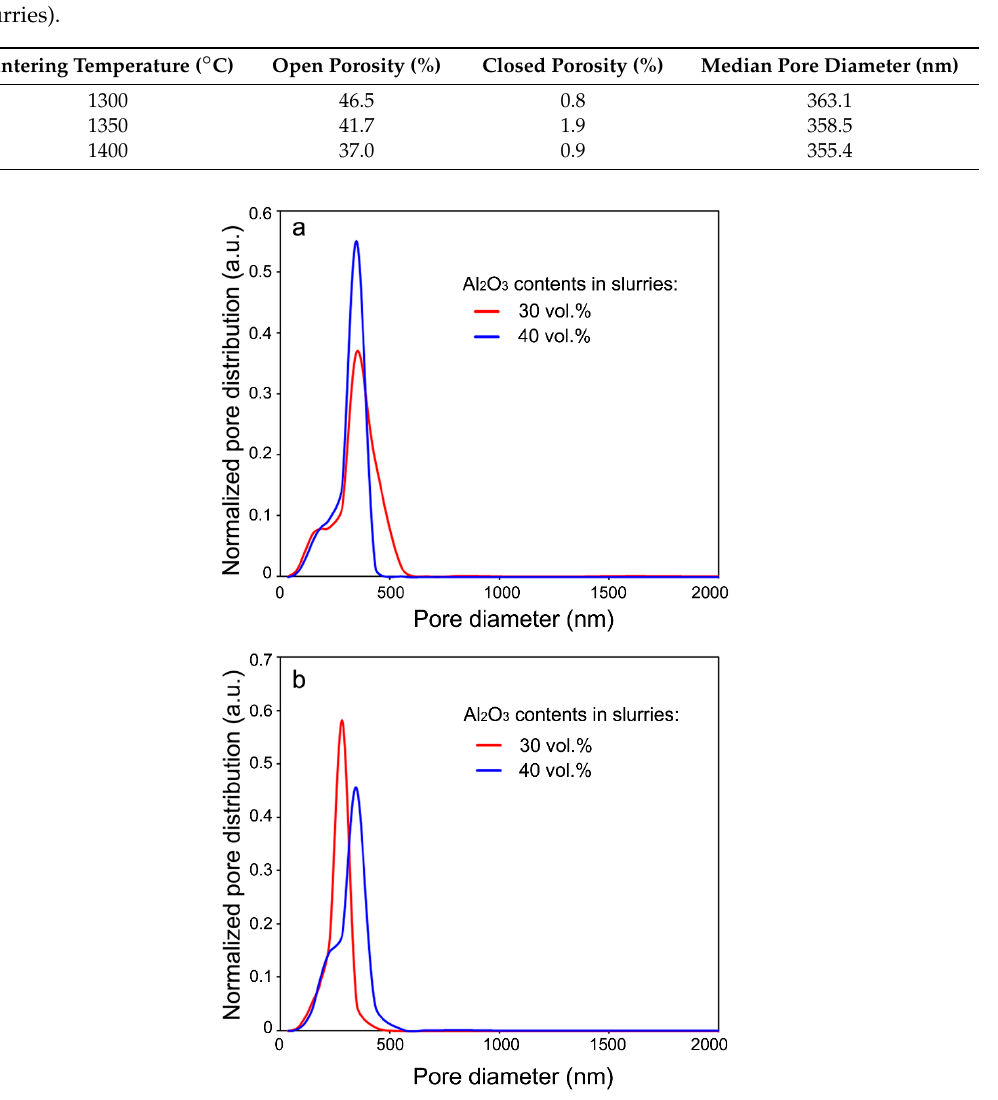
Figure 6. Normalized pore size distribution of porous Al 2 O 3 ceramics for the sintering temperatures of 1300 °C ( a ) and 1400 °C ( b ).